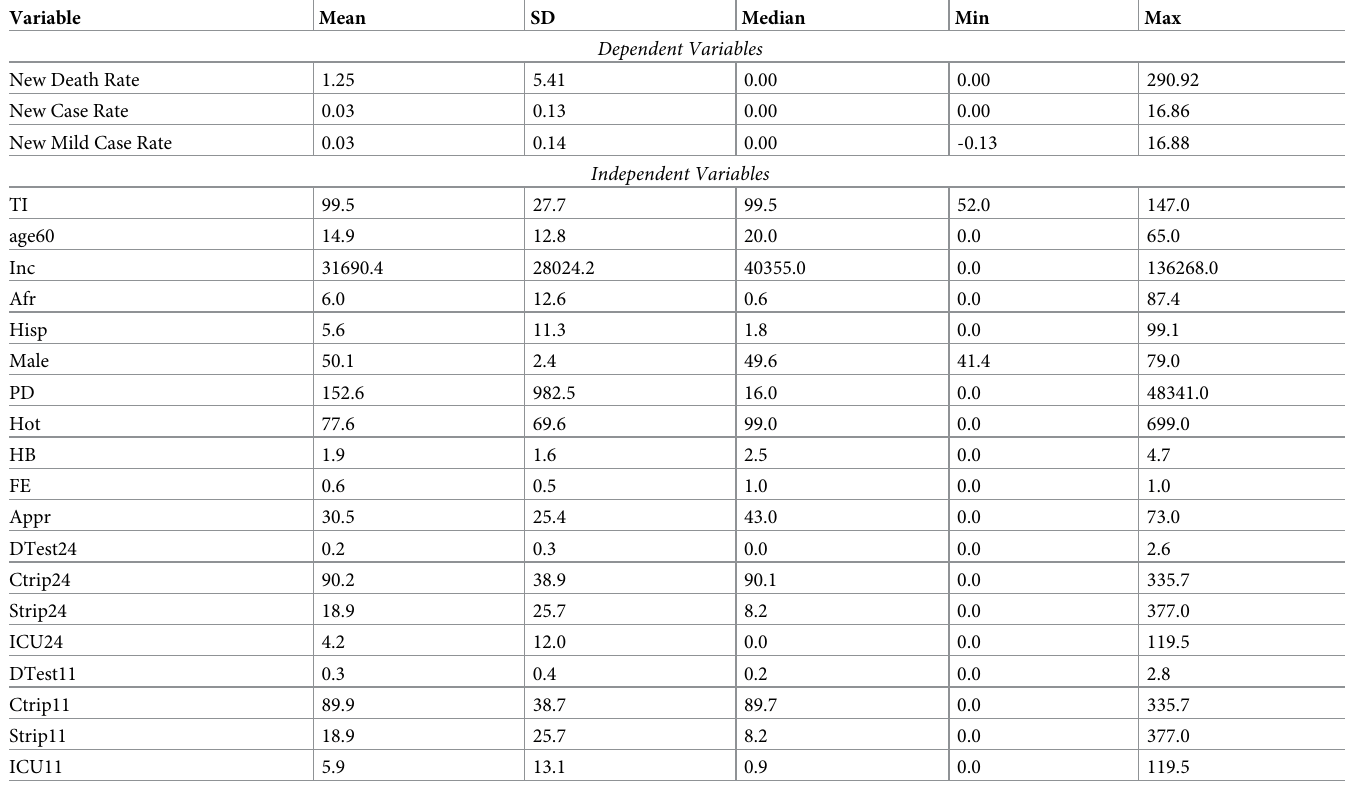
Table 2. Summary of